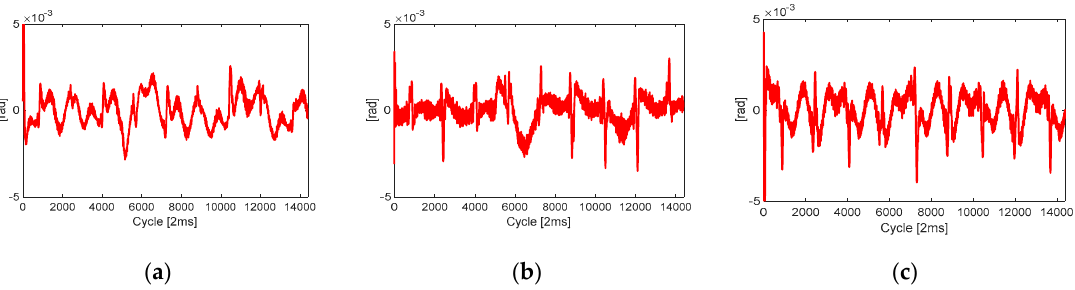
Figure 11. Tracking error at each joint with a single joint fault occurring at Joint 2. ( a ) Joint 1; ( b ) Joint 2; ( c ) Joint 3.